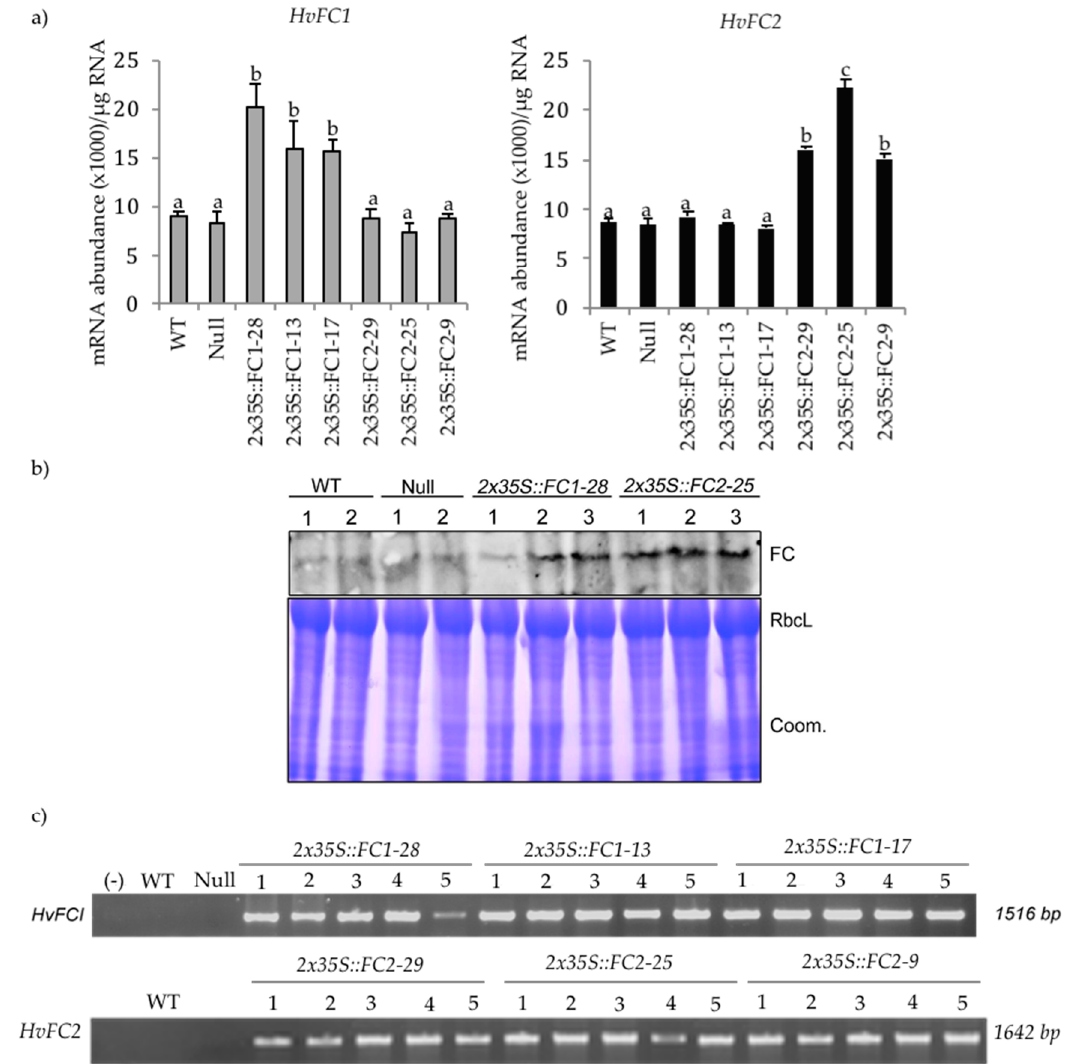
Figure 5. Molecular identification of HvFC overexpression lines. ( a ) Enhanced transcript levels of HvFC1 and HvFC2 , in three selected single-copy independent transformation events (T 1 ) relative to WT and null segregant controls (i.e., Lacking transgene). Data are presented as means ± standard error for six replicates. Means with the same letter are not significantly different at p < 0.05, one-way ANOVA. ( b ) Immunoblot analysis of HvFC in three biological replicates of the highest overexpressing transgenic lines ( 2 X 35S::FC1–28 and 2 X 35S::FC2–25 ) relative to WT and null controls. The Coomasie (Coom.)-stained blot served as a loading control. ( c ) Detection of the presence or absence of HvFC1 and HvFC2 transgenes using polymerase chain reaction (PCR) with transgene-specific primers. Lane (-) is a negative control (water). 1–5, five biological replicates for each independent transformation event.